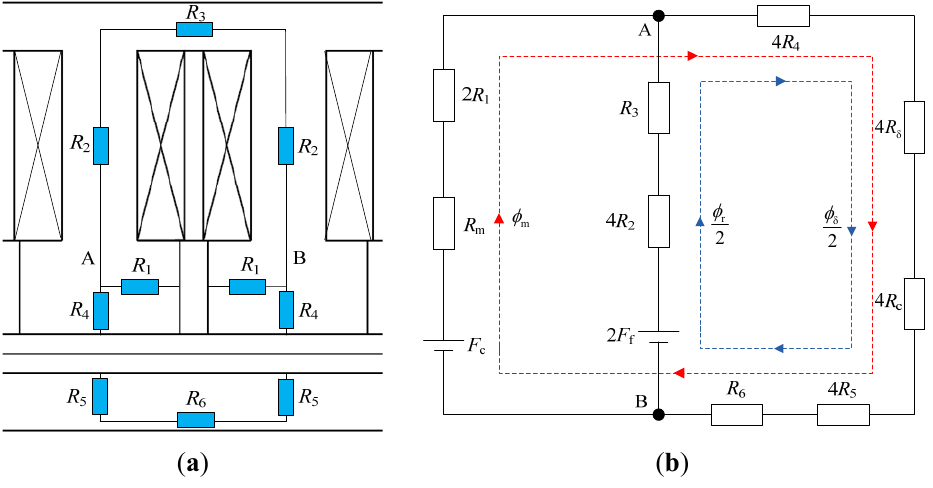
Figure 3. ( a ) Definition of iron part reluctances and ( b ) the magnetic equivalent